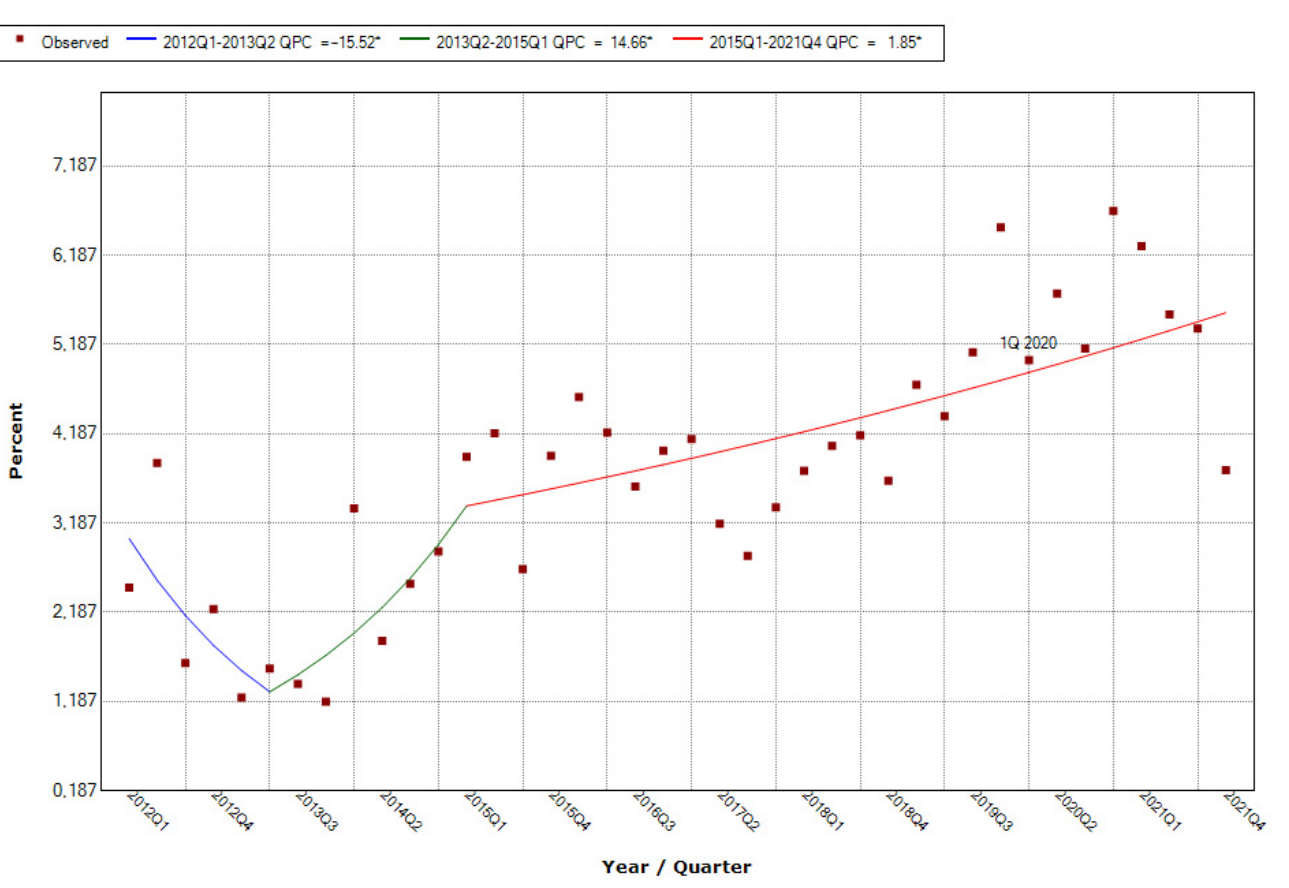
Figure A34. Percentage of products containing vitamin K in individual quarters in the period from 2012 to 28 November 2021. Joinpoints mark trend turning points. The date above the observation indicates the moment of publication of the scientific opinion/resolution.